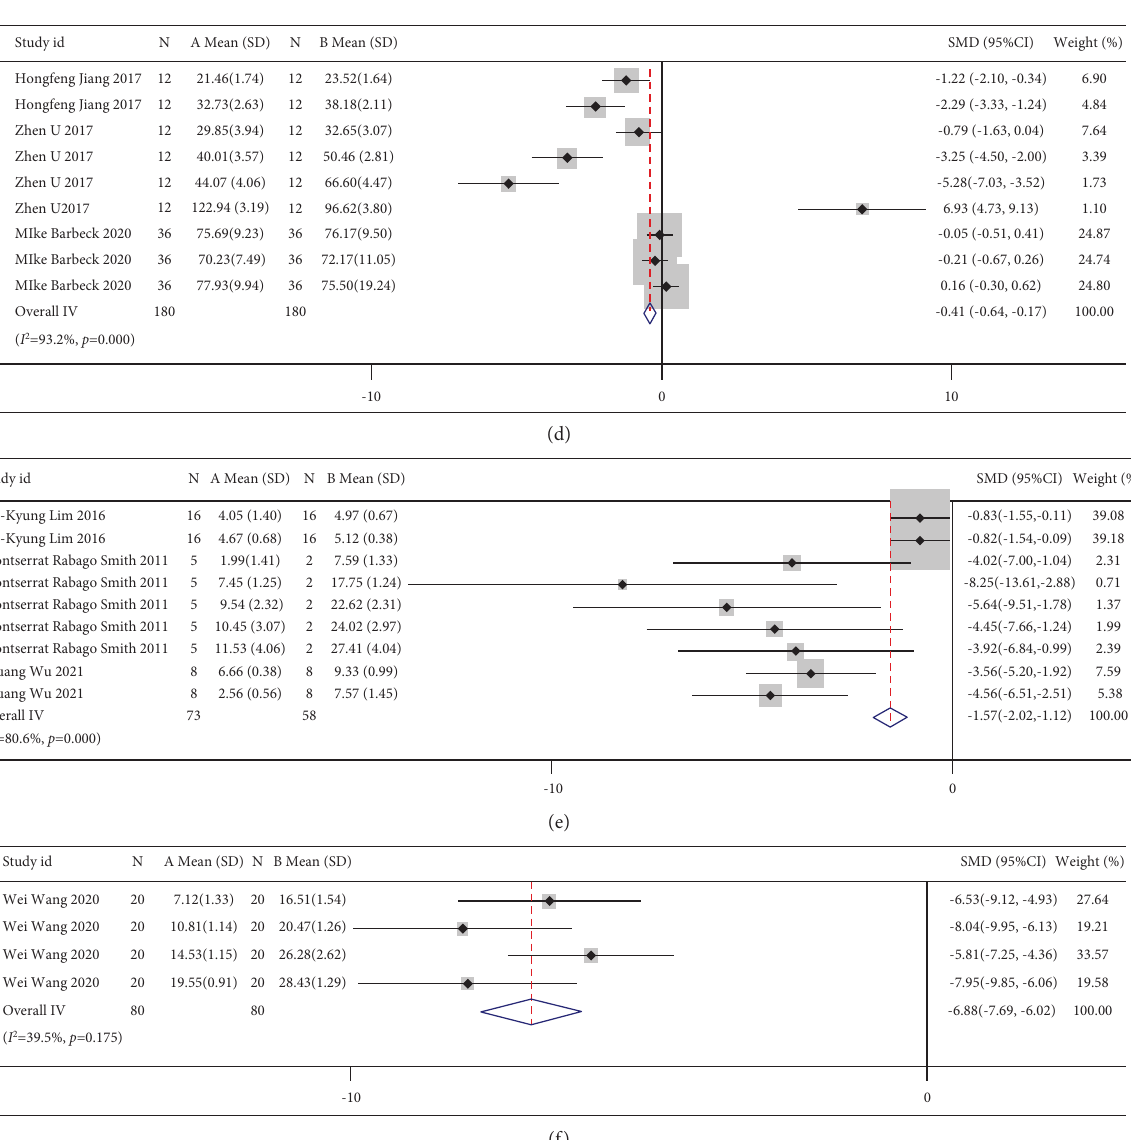
Figure 8: Forest plots of direct comparisons: (a) % degradation for BM vs. MAO-coated Mg, (b) % degradation for BM vs. FLU-coated Mg, (c) % degradation for BM vs. Ca-P-coated Mg, (d) new bone formation for BM vs. FLU-coated Mg, (e) new bone formation for BM vs. Ca-P- coated Mg, and (f) new bone formation for FLU-coated Mg vs. Ca-P-coated